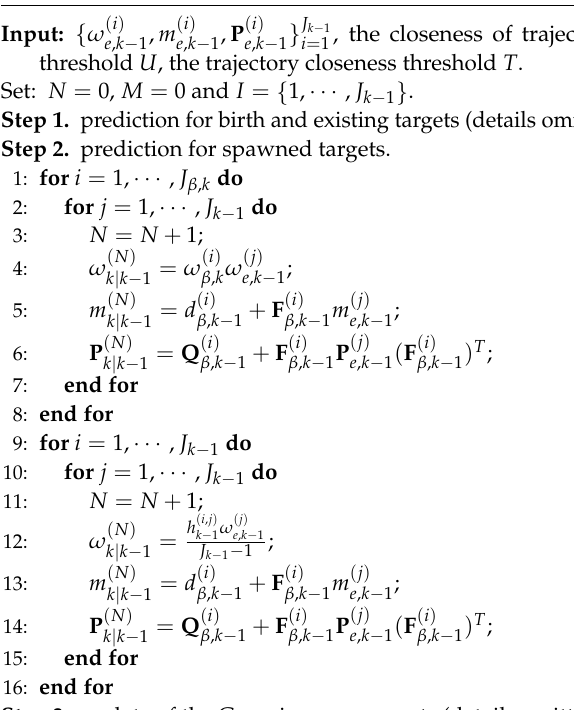
Algorithm 2 Pseudo-code for the spawned intensity